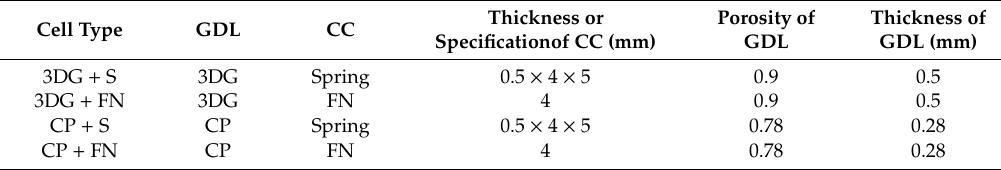
Figure 3. ( a )Cross-sectional view of the 3DG + S B- μ DMFC; ( b )the packaged B- μ DMFC. Table 1. Physical properties of the fourbutton-type micro direct methanol fuel cells(B- μ DMFCs). 3DG, three-dimensional graphene; S, springs; FN, foam nickel; CP, carbon paper; GDL, gas diffusion layer; CC, current collector.